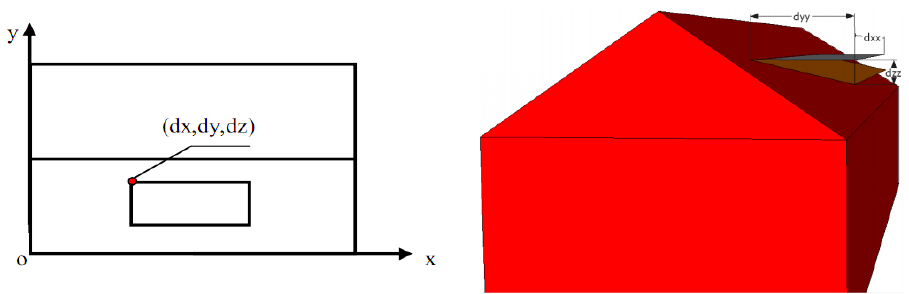
Figure 14. Shape parameters of the gabled roof with one